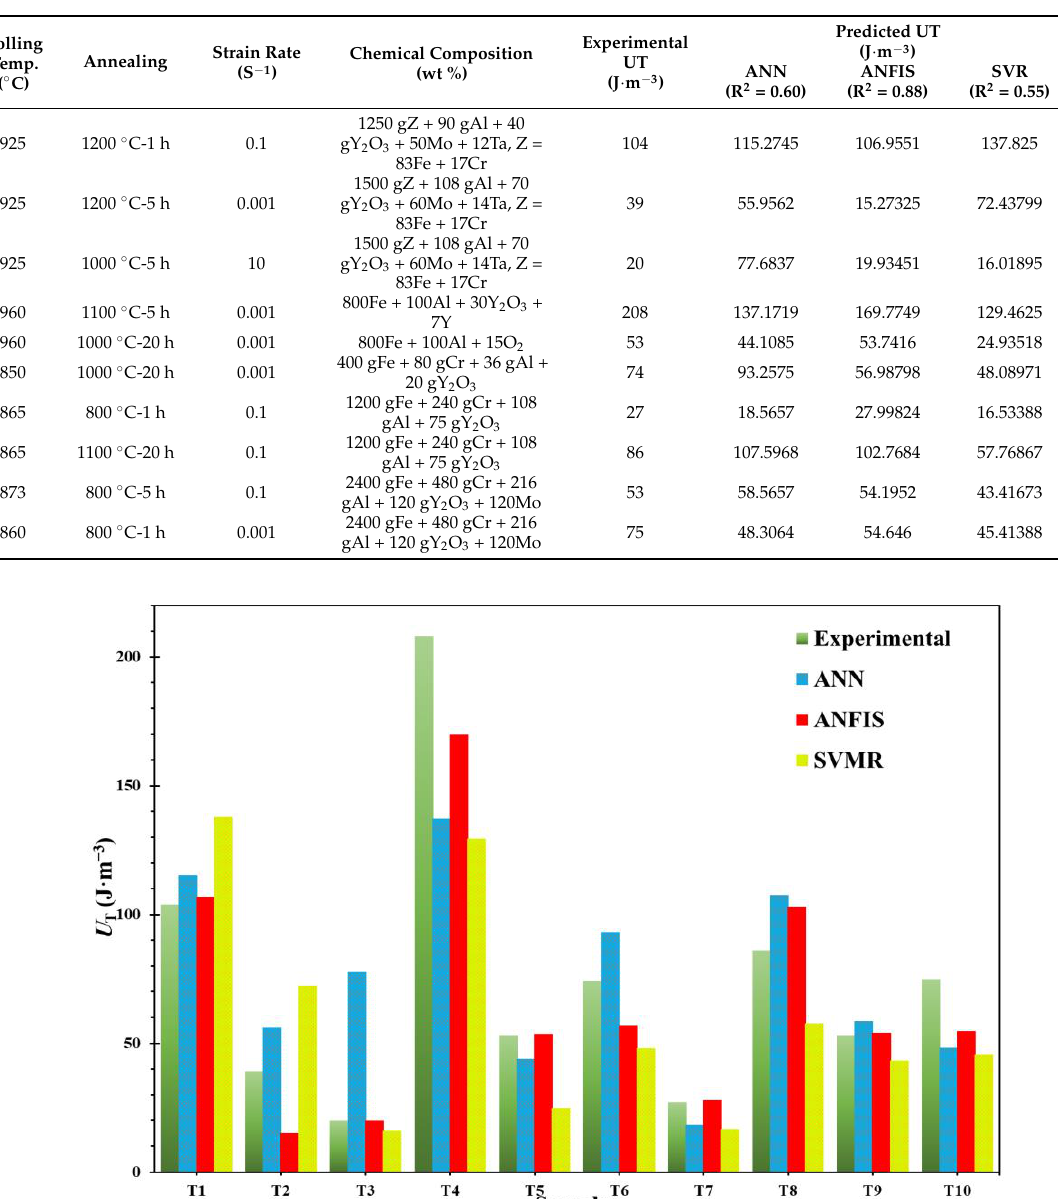
Table 5, these ten datasets (e.g., T1 to T10) were reported. Figure 5 and Table 5 illustrate the comparison between the experimental values and the modeling results. It could be understood that the predicted values are compatible with experimental values. However, the ANFIS model exhibited a better and more reliable prediction performance than the ANN and the SVR models. Therefore, we can say that the ANFIS model is more efficient than the other models. Table 5. The material parameters of the samples for testing the models with the prediction results. Material No.